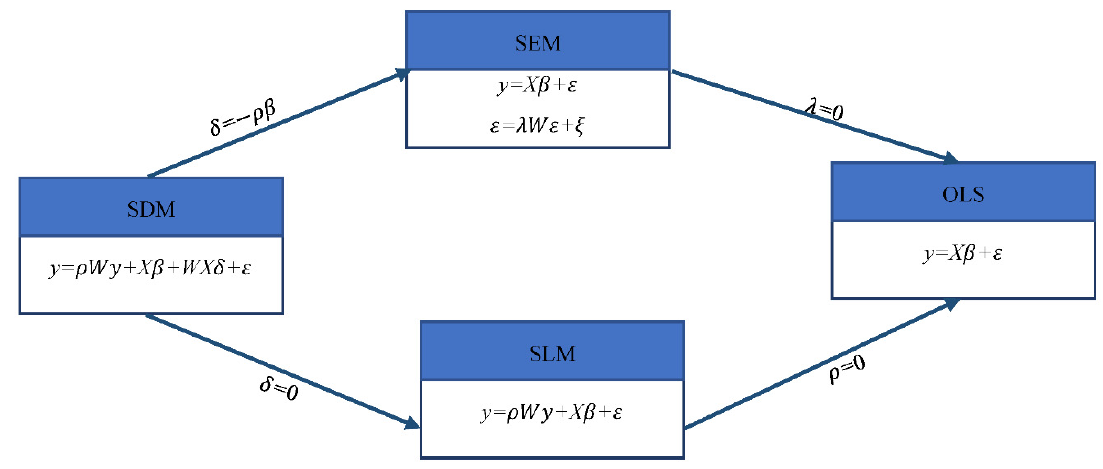
Figure 2. Transfer among spatial econometric models. The spatial error model (SEM), spatial lag model (SLM), and spatial Durbin model (SDM) are established in this paper, Equations (10)–(12). The optimal models were deter- mined based on the LR, LM, and WALD tests.